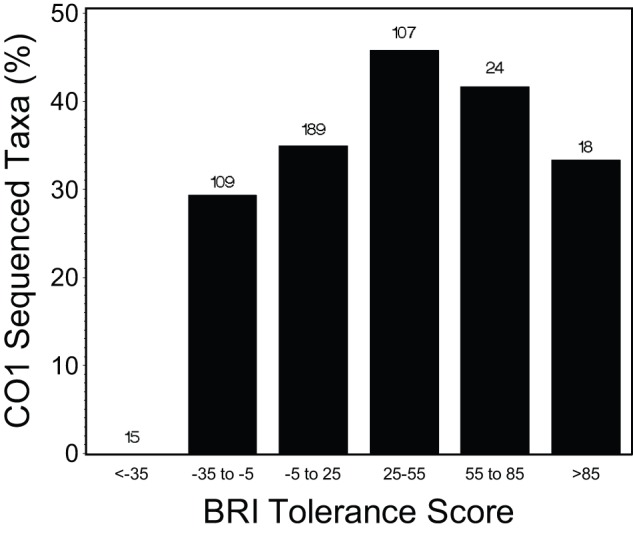
Percentages of taxa with BRI tolerance scores which have CO1 sequences available in the Barcode Of Life Database.Taxa were segregated into six categories along the disturbance gradient by BRI tolerance scores. The total number of taxa with tolerance scores in each category are presented above the bar indicating sequence availability. Barcodes were available for 163 of 462 taxa with tolerance scores.